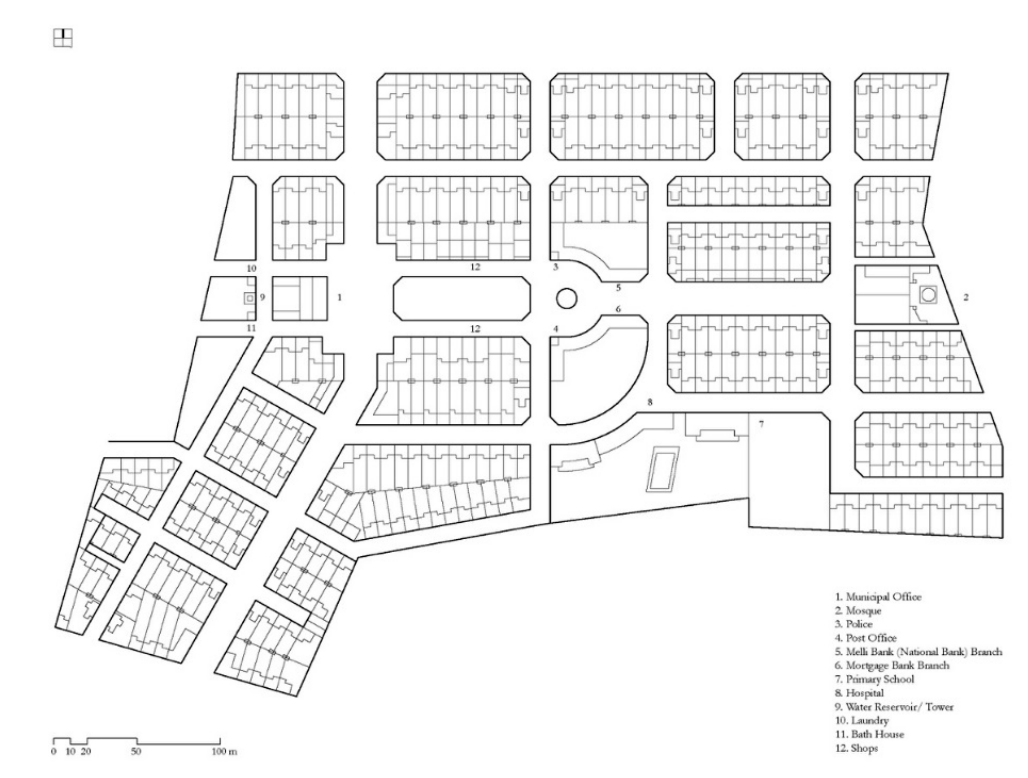
Figure 8. Plan of Chaharsad Dastgah housing project. Source: author.